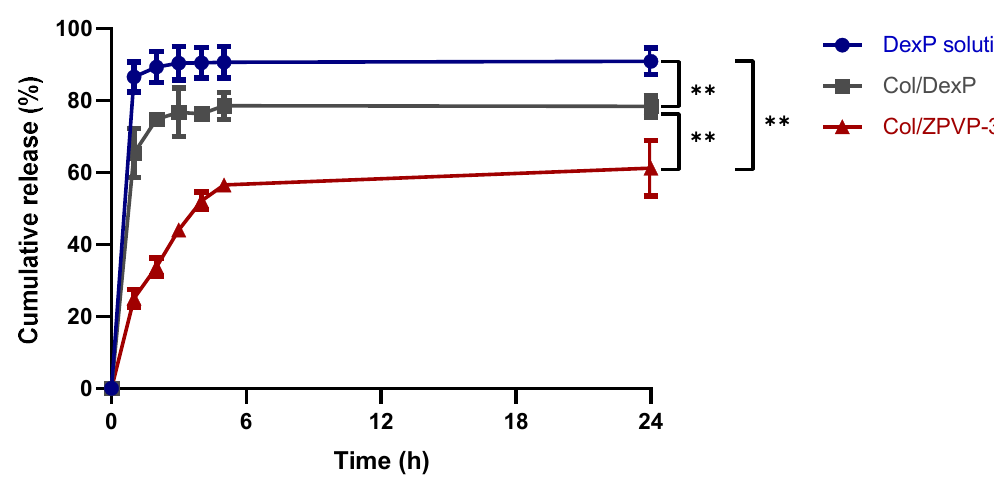
Figure 6. In vitro DexP release profiles in PBS (pH 7.4) at 37 °C from a DexP solution, Col/DexP and Col/ZPVP-3. Error bars represent SD, n = 3; ns = non-significant ( p > 0.05); ** p ≤ 0.01.